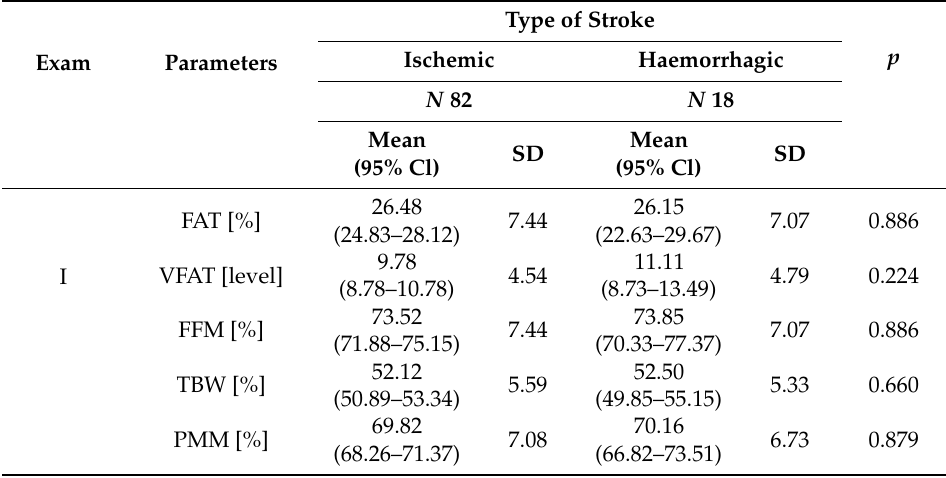
Table 3. Body mass components versus type of